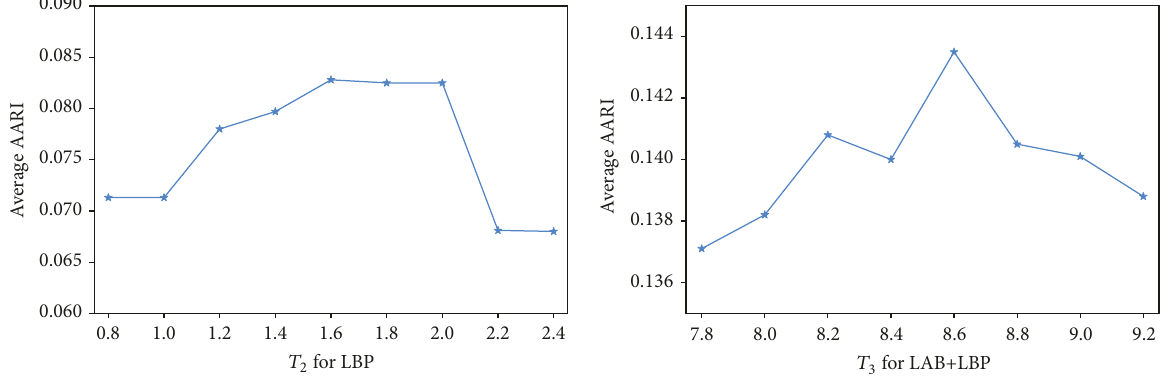
Figure 6: Average AARI of training data varying with threshold.